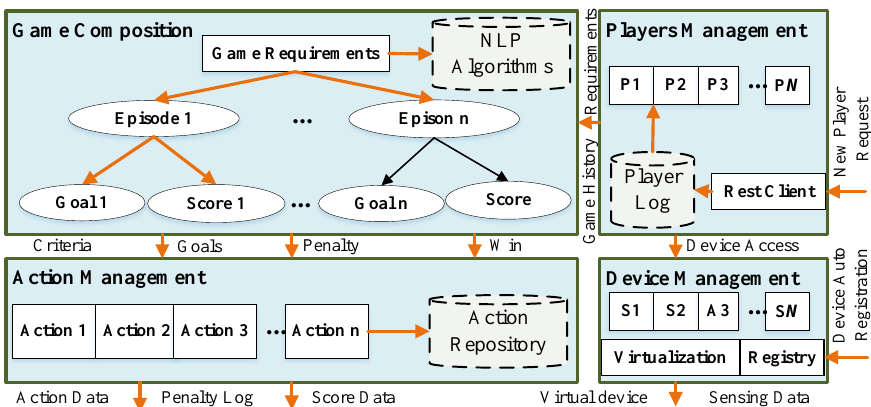
Figure 2. Modular representation of the application management